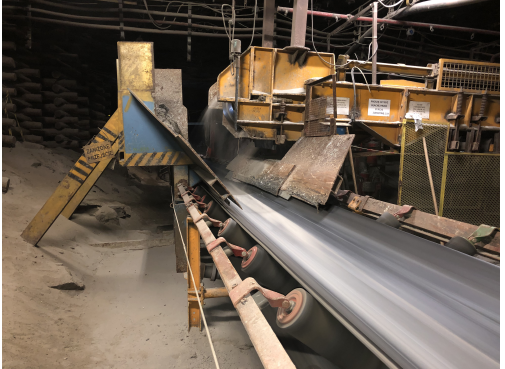
Figure 1. Research object—perpendicular, angular transfer point in an underground copper ore